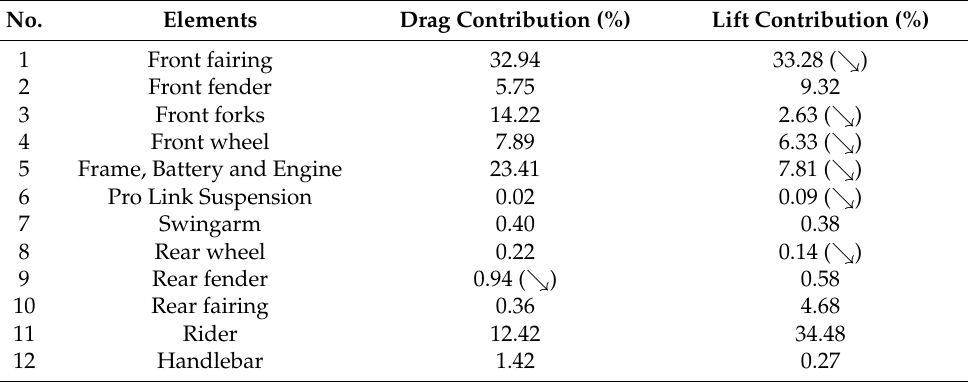
Table 2. Percentage contribution of each component to the drag and lift force values.